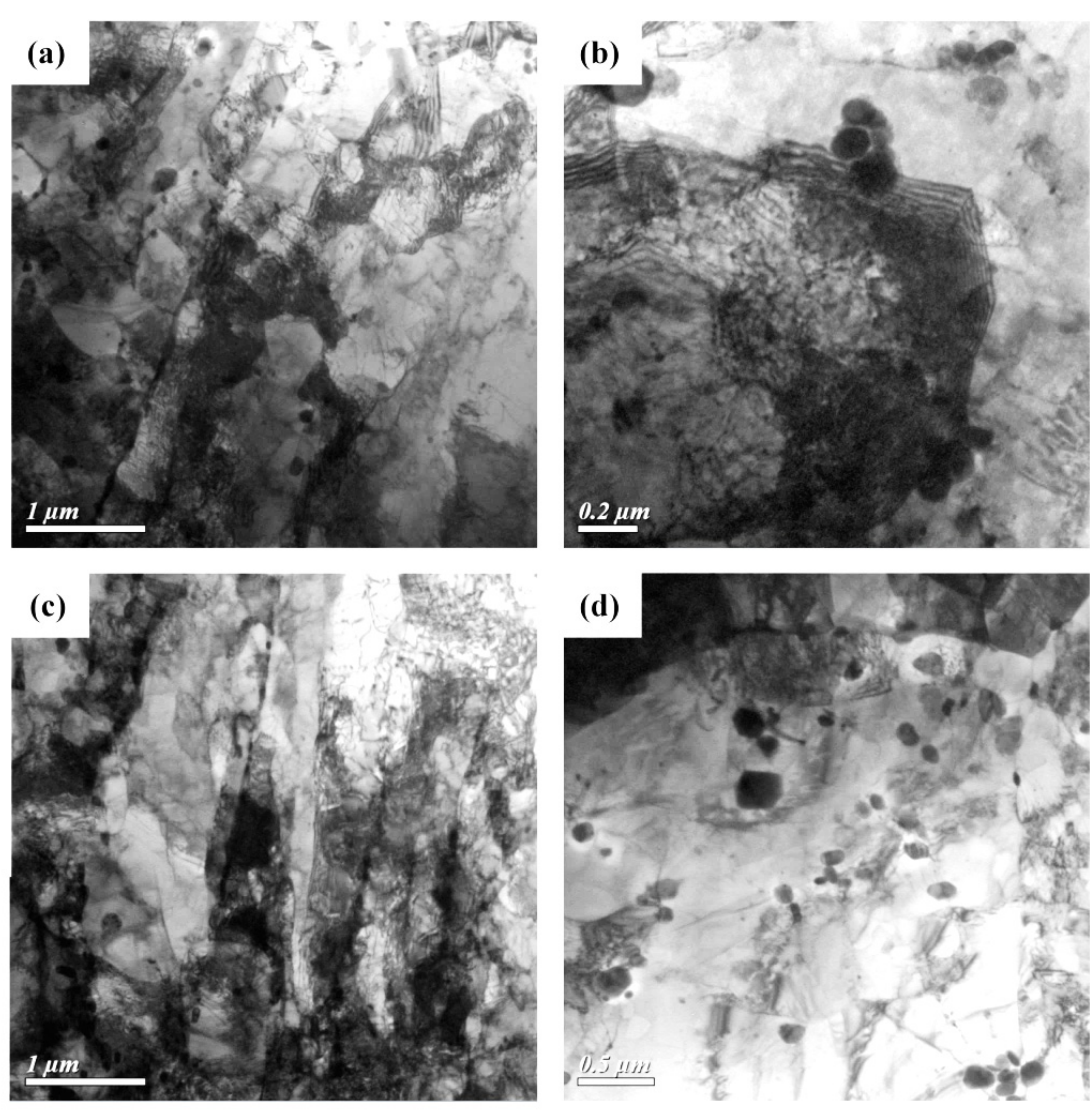
Figure 6. TEM micrographs of the ( a , b ) WP-800P and ( c , d ) WP-860P samples.